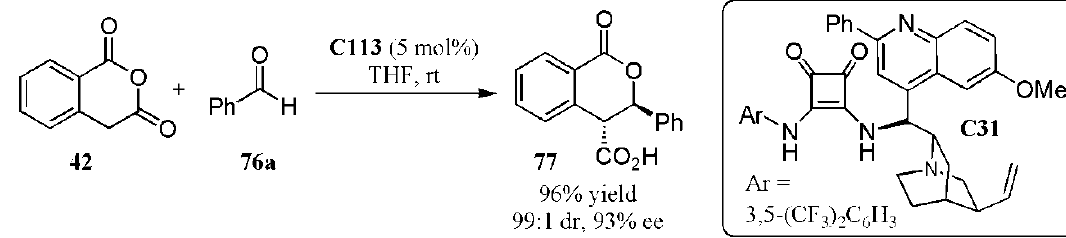
Figure 42. The organocatalytic asymmetric reaction of benzaldehyde and homophthalic anhydride [82].